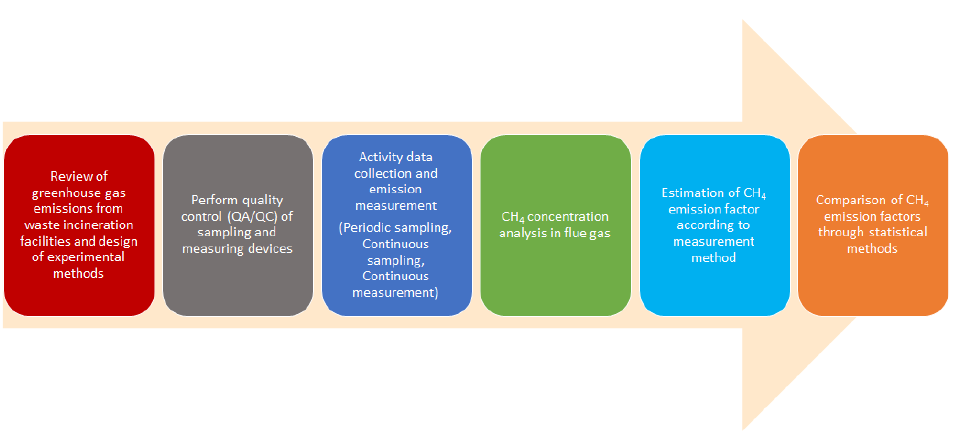
Figure 1. The research procedure diagram of this study.